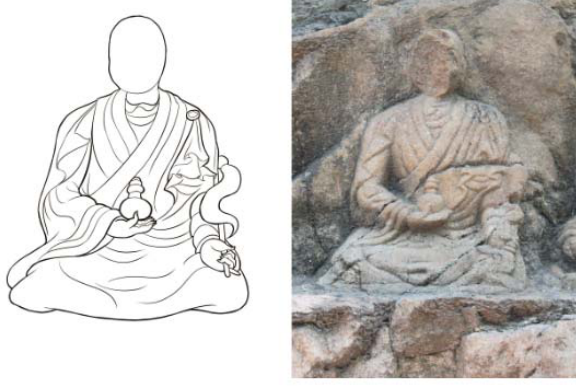
Fig.14. A Line drawing of a statue of Buddha in the Garden of Gathering spring 赅春园 ,